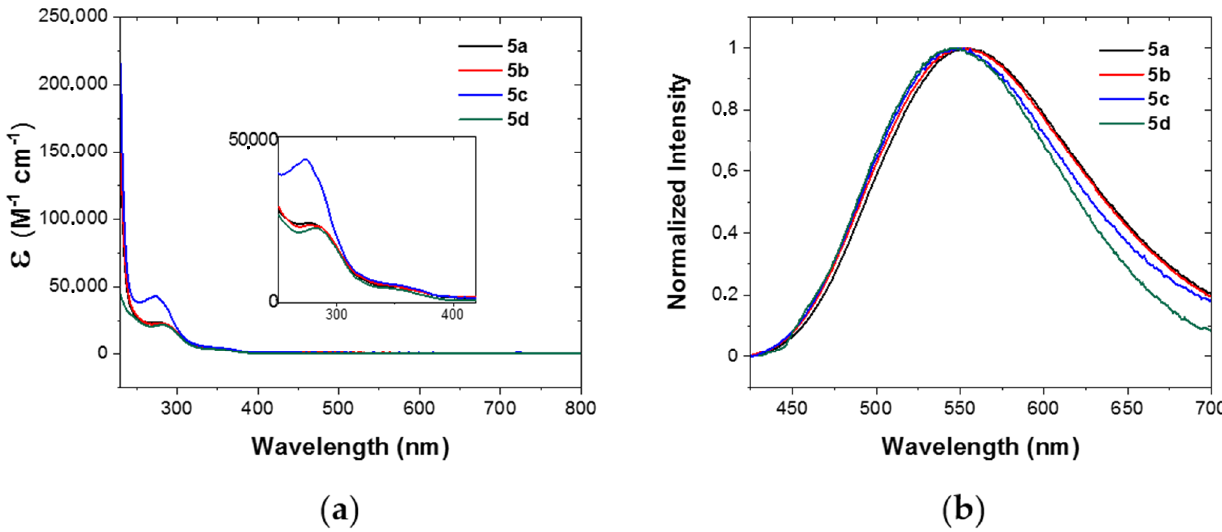
Figure 5. UV–vis spectroscopy of complexes 5a (black curves); 5b (red curves); 5c (blue curves); and 5d (green curves) in DCM solutions at r.t. ( a ) Molar extinction coefficients ( ε ) in the UV–visible range of the electromagnetic spectrum—a zoom-in is shown in the inset; ( b ) emission of Ar-saturated solutions (concentration ~ µ M; λ exc = 370 nm).